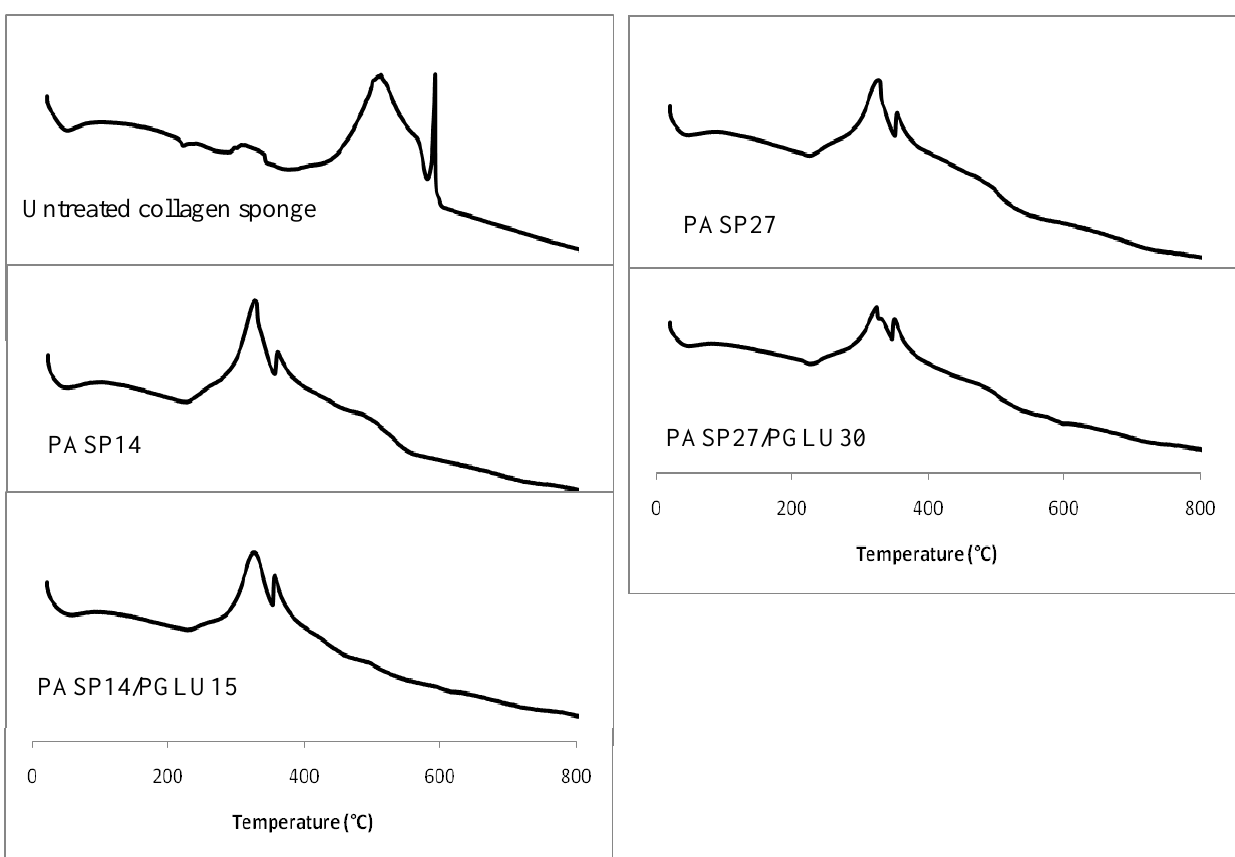
Figure 10. DTA curves of collagen sponges mineralized via the polymer-aided process. PILP-mineralized collagen samples treated with 50 µg/mL poly-L-aspartic acid or combinations with poly-L-glutamic acid for 3 days show a shift in the thermal decomposition profiles to lower values (320°), as compared to the untreated collagen sponge